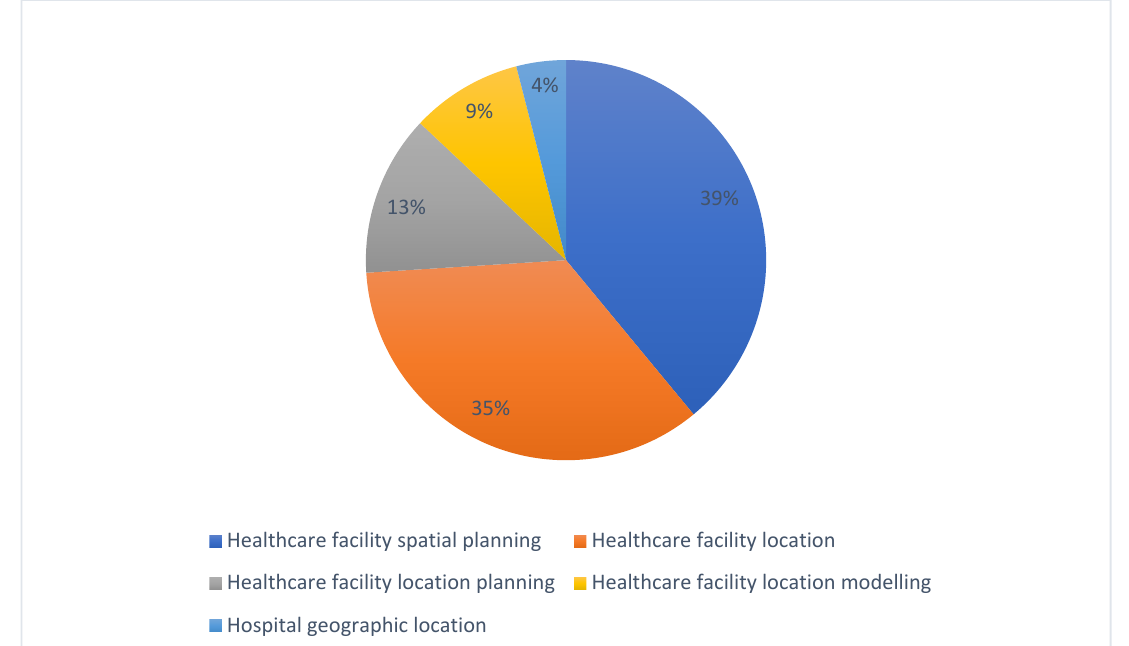
Figure 2. Percentage of key search criteria for the studies that underwent full text review.